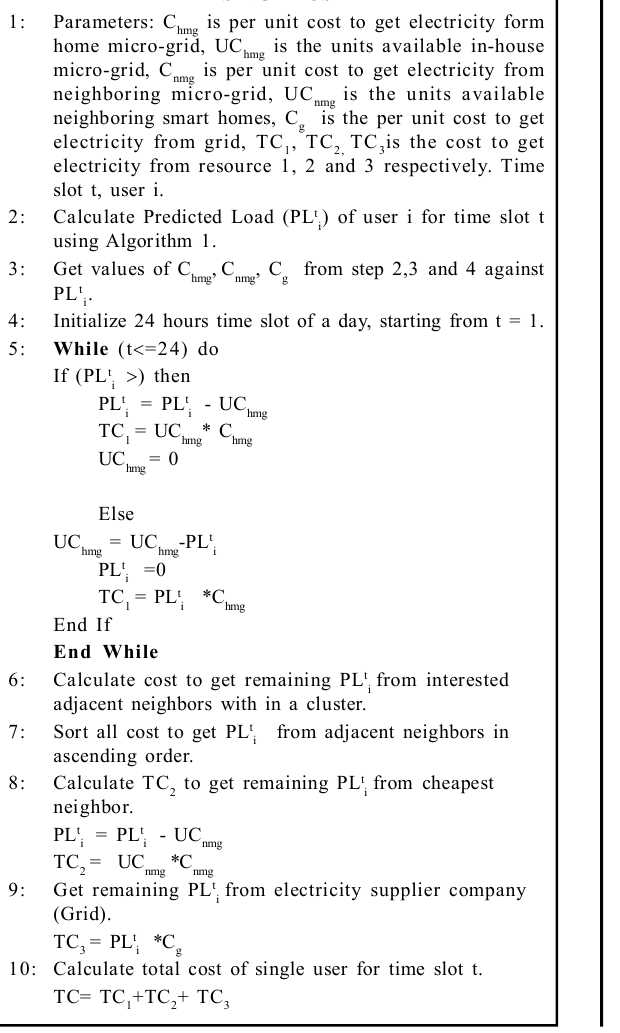
ALGORITHM-2: UTILITY BILL CALCULATI ON FOR SINGLE USER